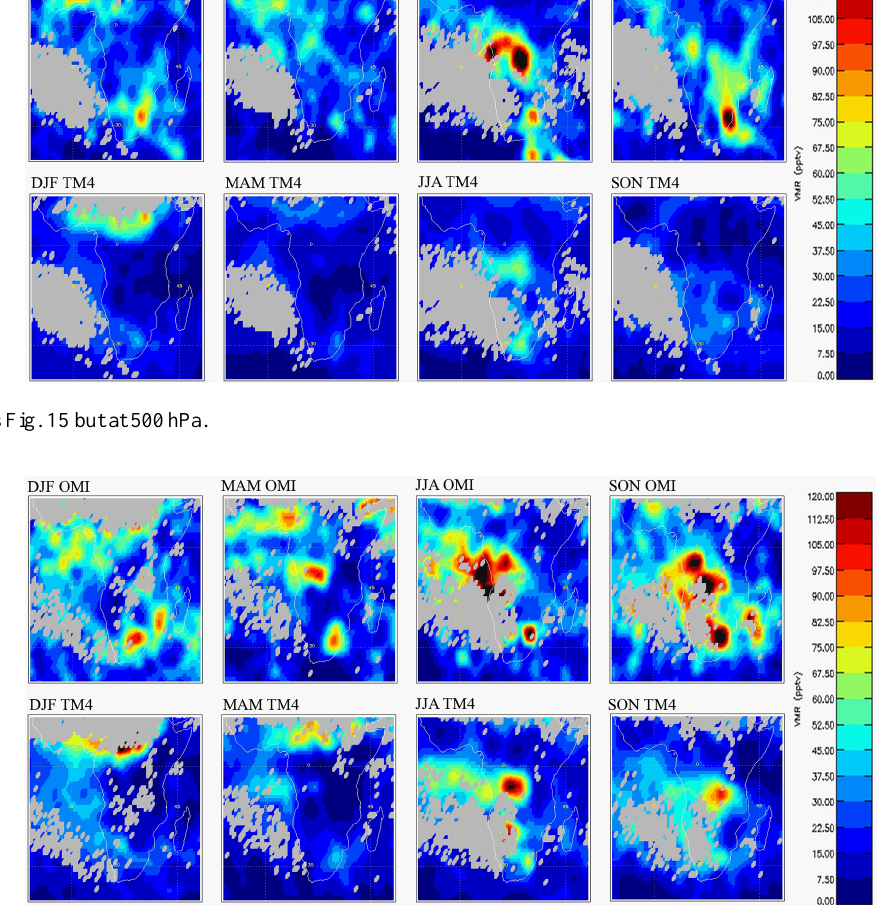
Figure 18. Same as Fig. 15 but at